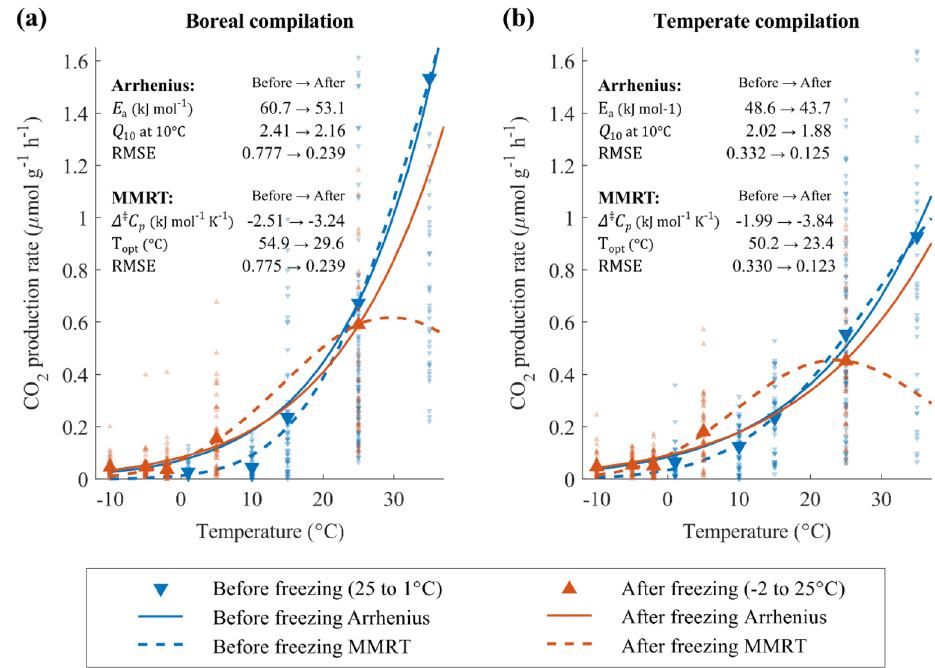
Figure 5. The grouped CO 2 production rates for boreal ( a ) and temperate ( b ) ecoclimate (as in Fig. 4). The data points and fitted lines correspond to one of the two cases: before or after the start of sub-zero temperatures ( i.e. , ‘before freezing’: from the first temperature setting at 25 °C to 1 °C; and “after freezing”: from the − 2 °C to the last 25 °C setting; see Fig. 4 x-axis for the incubation temperature steps). Data are fitted to both the Arrhenius and MMRT models (see Methods). The light symbols show all the rate data collected at a given temperature, the darker symbols are the mean